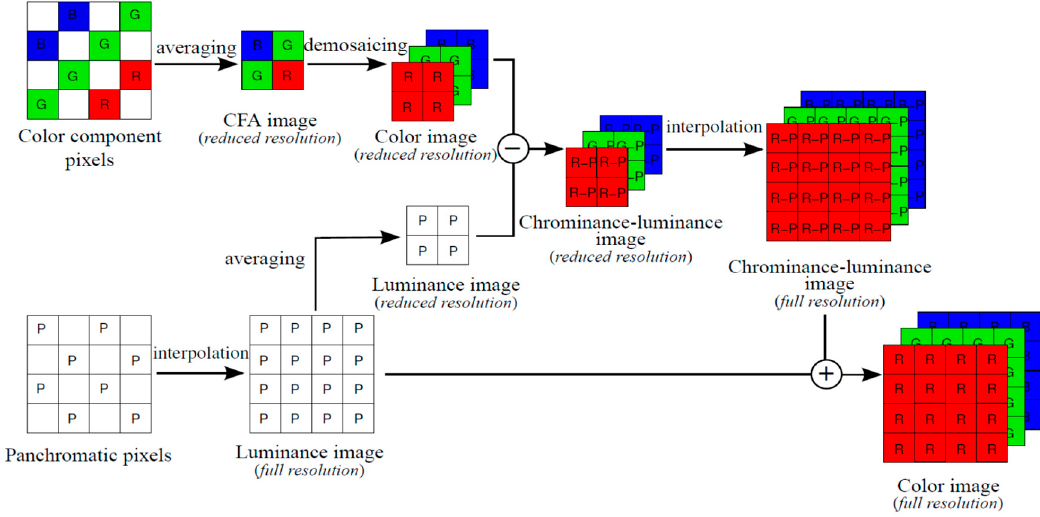
Figure 2. Standard approach to debayering CFA2.0 images. Image from [2].